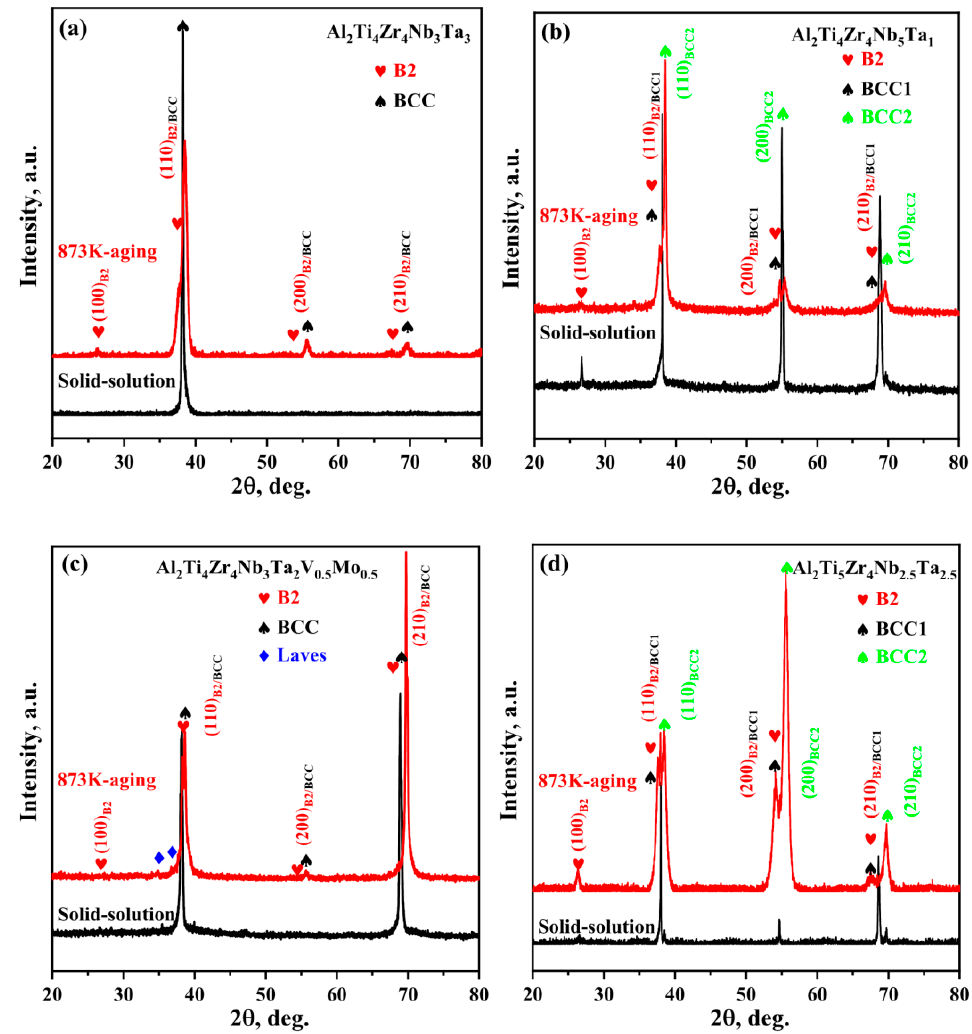
Figure 1. XRD patterns of the series RHEAs at solid-solutioned and 873 K-aged states. ( a – d ): S0, S1, S2 and S3, respectively.